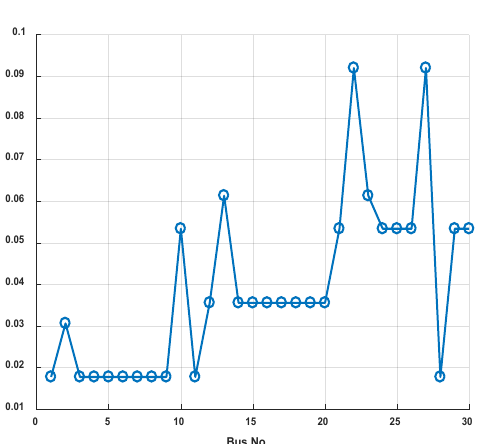
Figure 5. Analysis of voltage